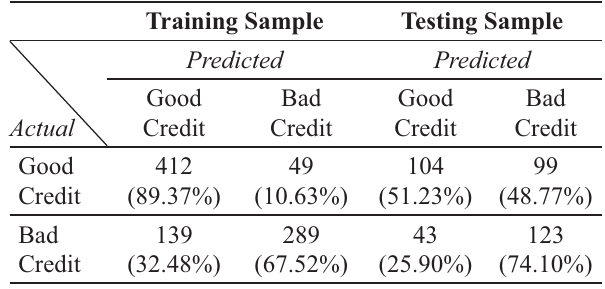
Table 3. Classifi cation results using Neural Networks for training and testing samples